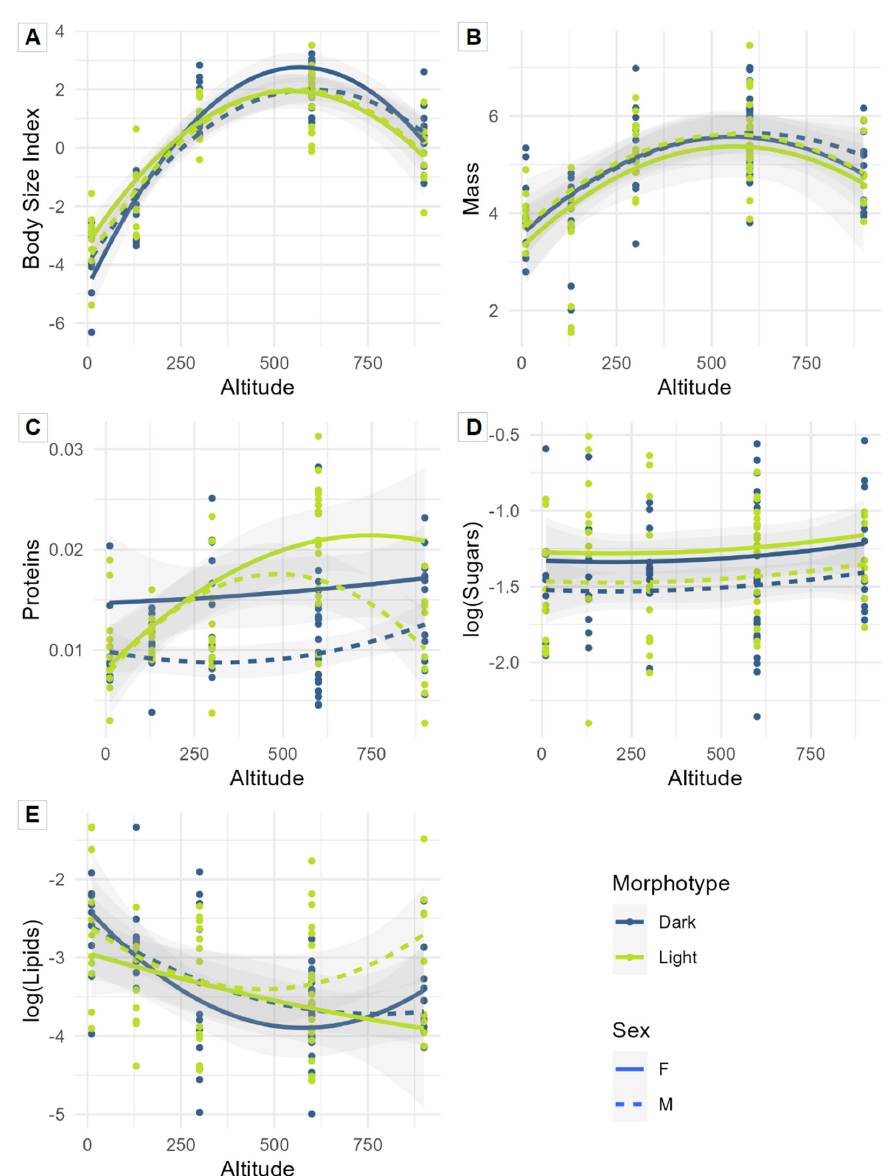
Figure 3. Predicted relationships (linear mixed models with site as a random factor) between altitude and the five measured functional traits for each sex (females: solid line, males: dashed line) and morphotype (dark morphotype: blue line; light morphotype: green line). Response variables: A— Body size index; B— Mass; C— Proteins/mass ratio; D— Sugars/mass ratio; and E— Lipids/mass ratio. The two last ratios were log-transformed.